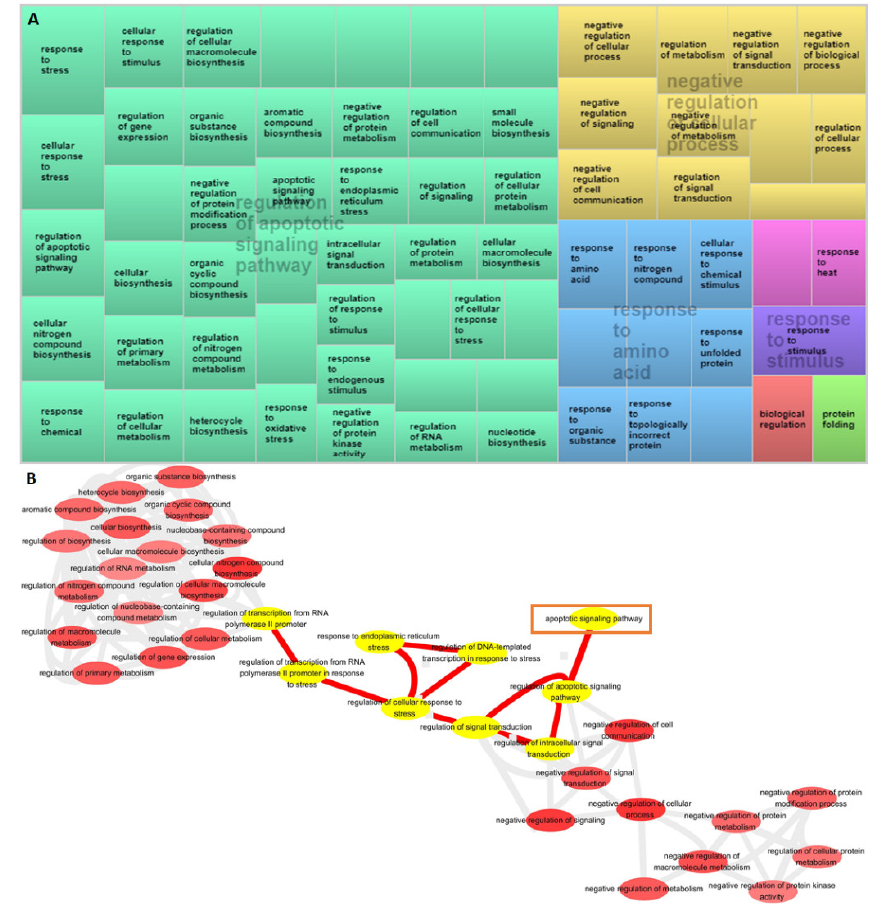
Figure 4. Gene Ontology (GO) enrichment analysis of differentially expressed genes based on over-representation analysis (ORA). ( A ) Enrichment of DEGs among biological process category in IS-treated astrocytes. Treemaps of DEGs generated using REVIGO. Each rectangle is a single cluster representative. The representatives are joined into “superclusters” of loosely related terms, visualized with different colors. Similar colors denote semantic similarity, and the dimension of the area is proportional to the overall direction of impact. Sizes of the rectangles reflect either the p -value or the frequency of the GO term in a given cluster. ( B ) REVIGO interactive graph accessed using Gorilla-summarized gene ontology biological process categories.